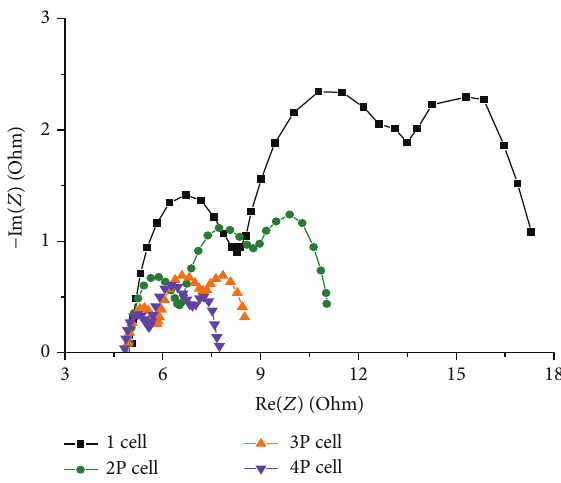
Figure 6: Cells connected module assembly in parallel connection.